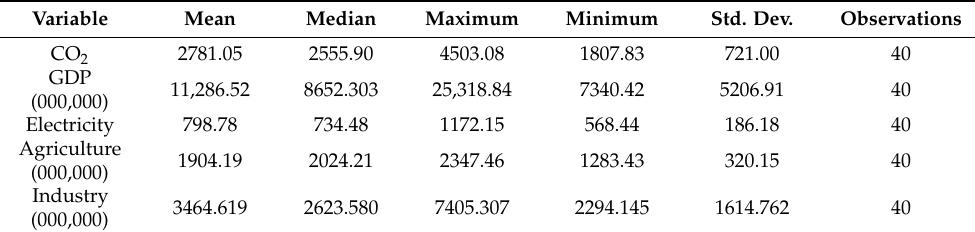
Table 1. Descriptive statistics of the variables used in this